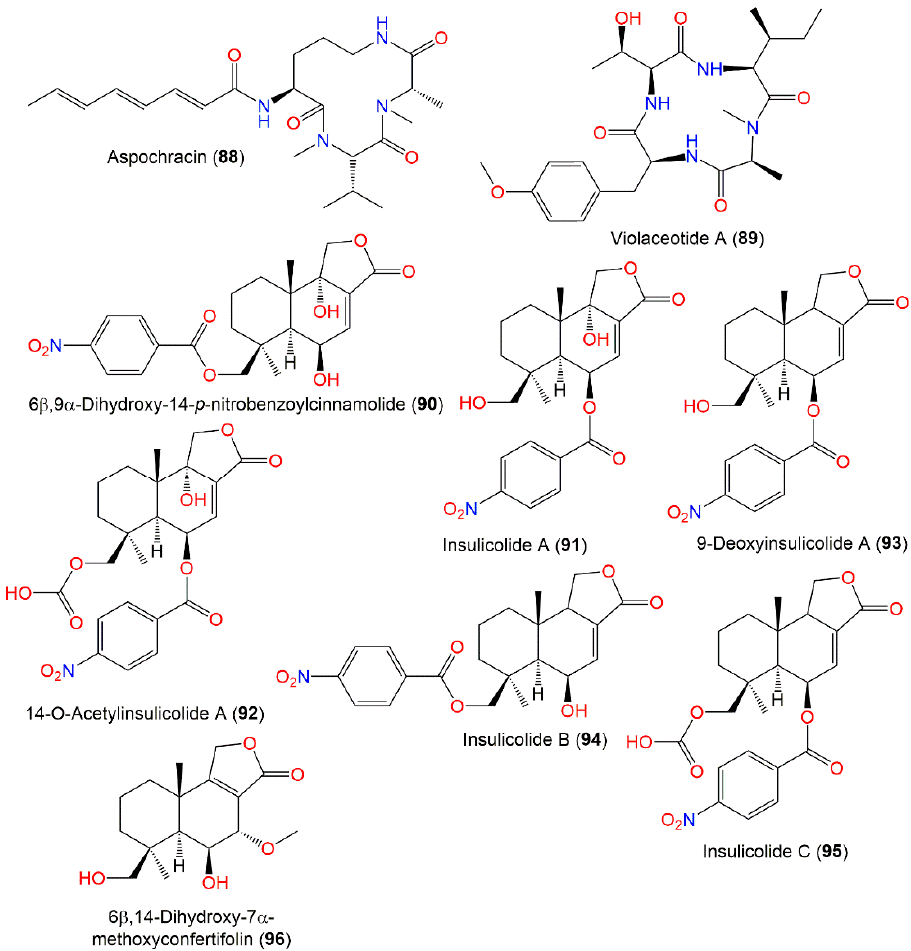
Figure 9. Peptides ( 88 – 89 ) and sesquiterpenoids ( 90 – 96 ) reported from A. ochraceus.